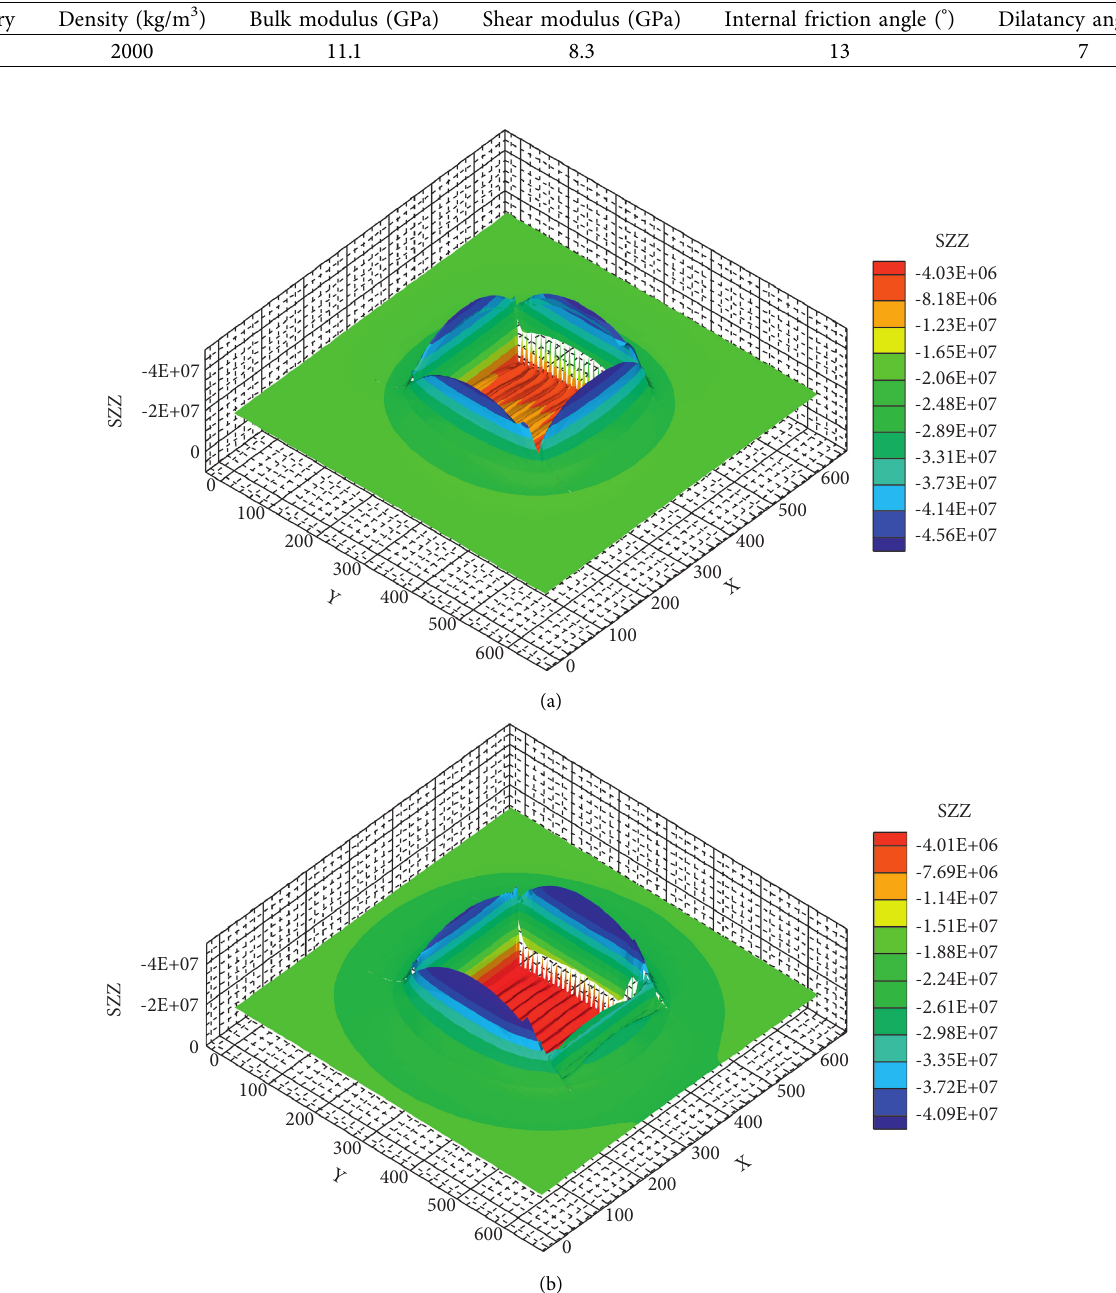
Figure 9: Curve of stress change of surrounding rock 5m from support to coal wall. (a) Before cutting the roof. (b) After cutting the